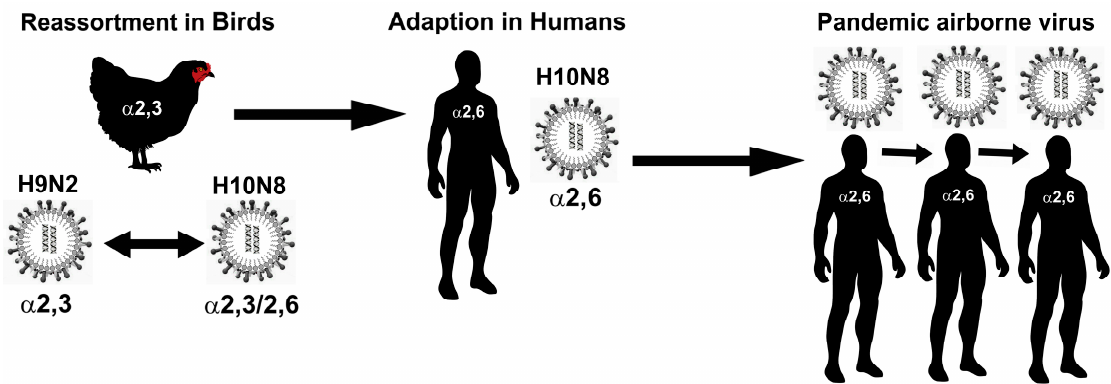
Figure 1. Zoonotic transmission of influenza H10 from birds to humans: a potential pandemic